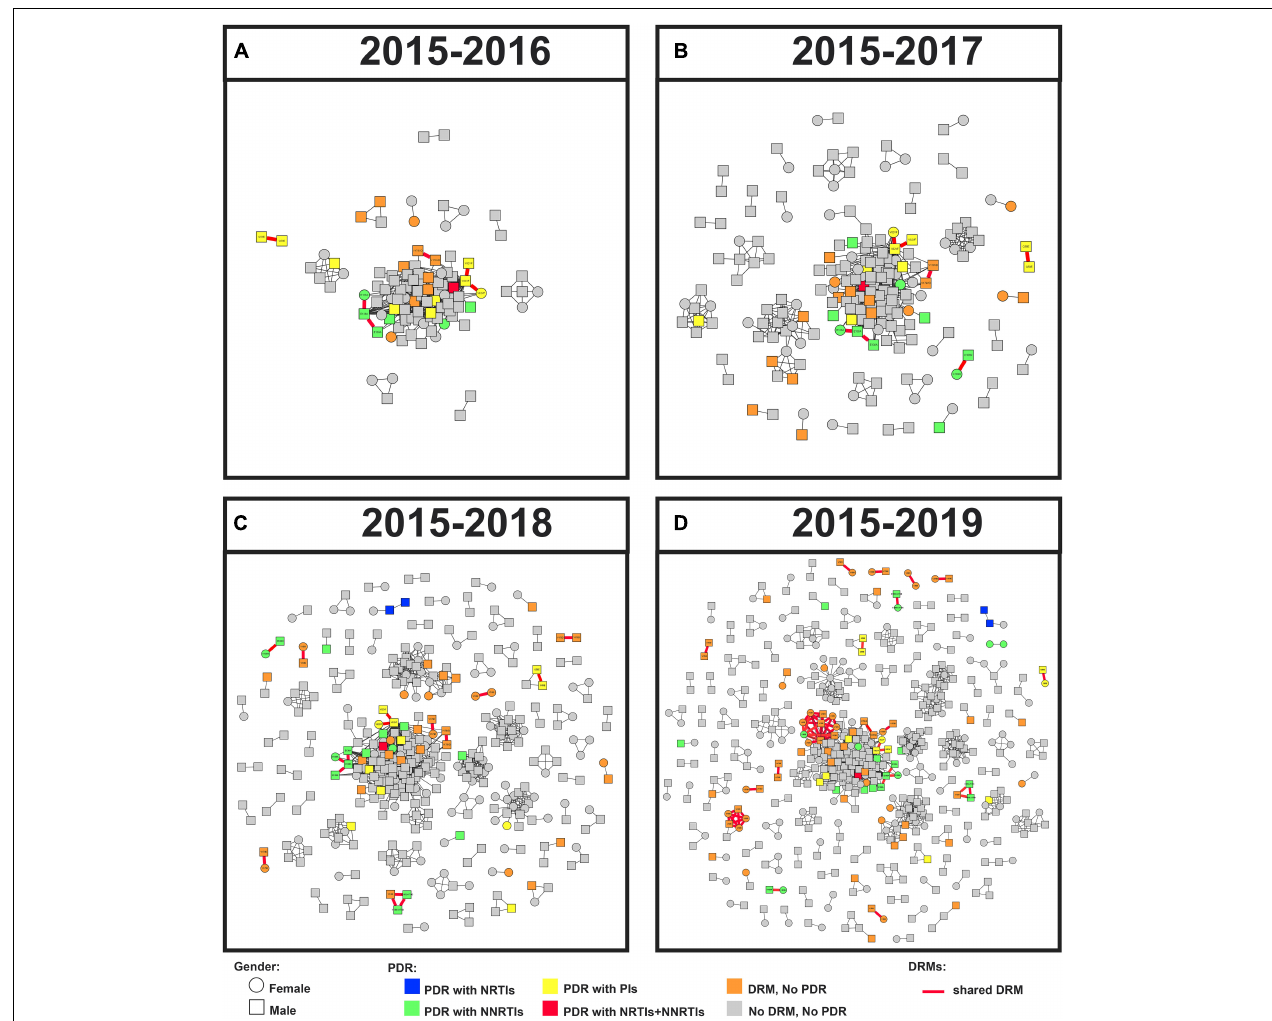
FIGURE 4 | Linked DRM and PDR, and cluster growth of the HIV-1 genetic network in Guangxi, 2015–2019. Squares and circles denote male and female. Nodes were colored by the presence of HIV-1 DRM and PDR. All edges represent a GD of < 1.5%. Edges in bold red indicate individuals who shared DRM. And shared DRM were labeled with each node. Annual growth of the genetic network is shown from panels (A–D)